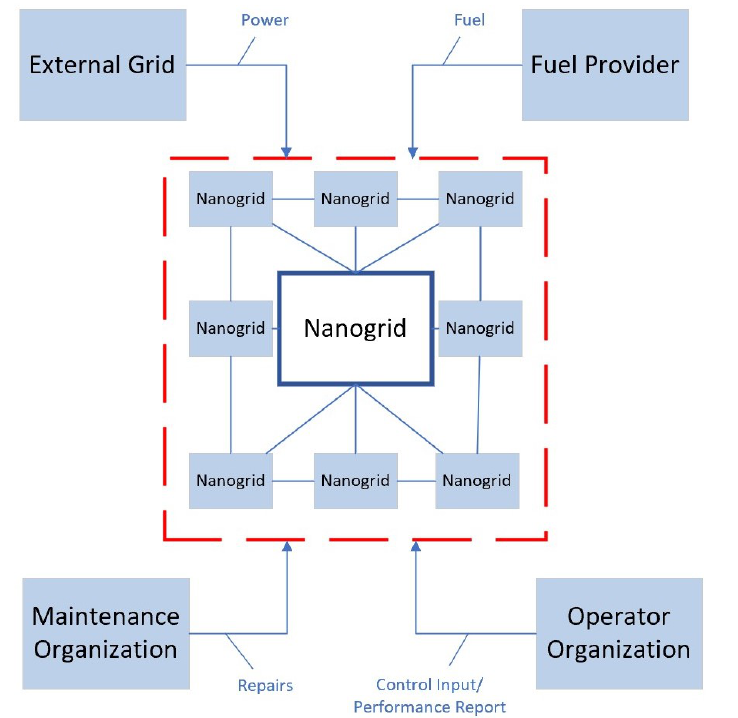
Figure 2. Nanogrid Context Diagram [2]. This diagram is useful in the context of the systems engineering process to identify external interactions with the system and identify system boundaries.